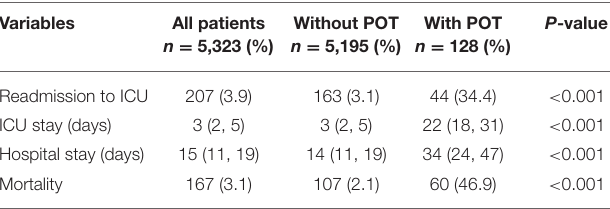
TABLE 4 | Postoperative variables in patients with and without POT after cardiac surgery.